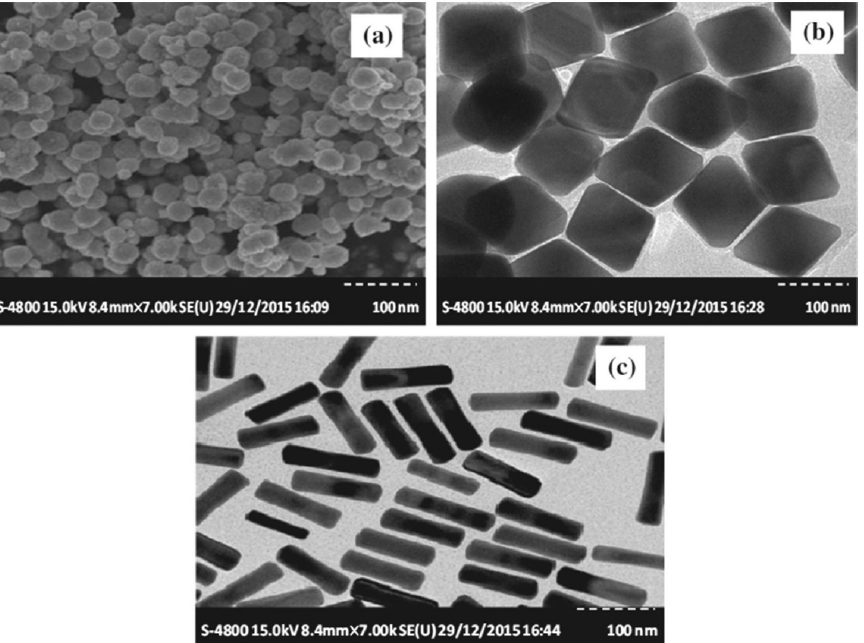
Figure 6. TiO 2 nanoparticle SEM images of ( a ) spherical, ( b ) brick (cubic), and ( c ) cylindrical (rod) shapes [57].